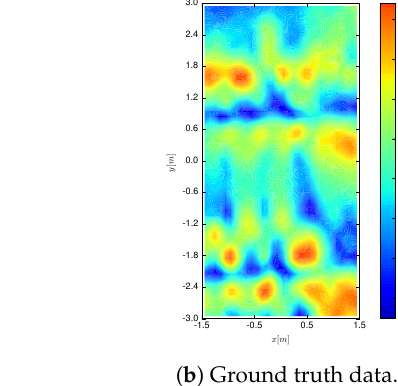
Figure 9. Ground-based robot exploring the magnetic field intensity within an indoor environment populated with obstacles. The projection on the ground corresponds to the actual magnetic field intensity, which we measured prior to the experiment to use it as ground truth. The magnetic field intensity ranges between 5 and 84 µ